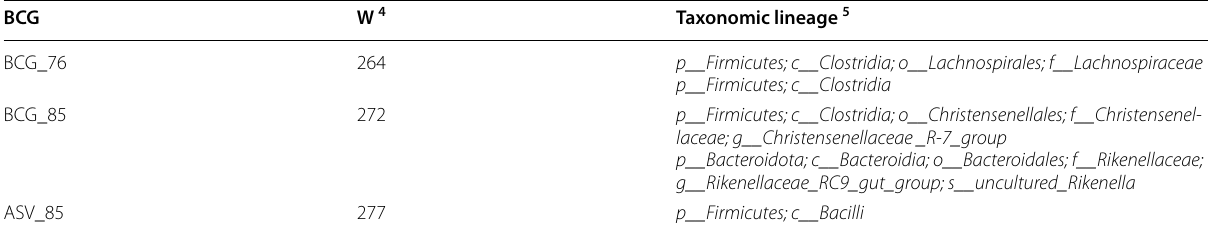
Table 2 Differentially abundant 1 bacterial co‑abundance groups (BCG) 2 and ungrouped amplicon sequence variants (ASV) across transitions